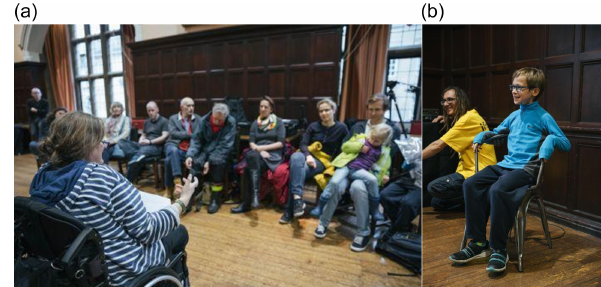
Figure 8. (a) Juliet Robson introduces hertz to the public at the Ox- ford Science and Ideas Festival, October 2018. (b) A young member of the audience experiences the reverberations of infrasound from the Oxford locality through one of the metal chairs.